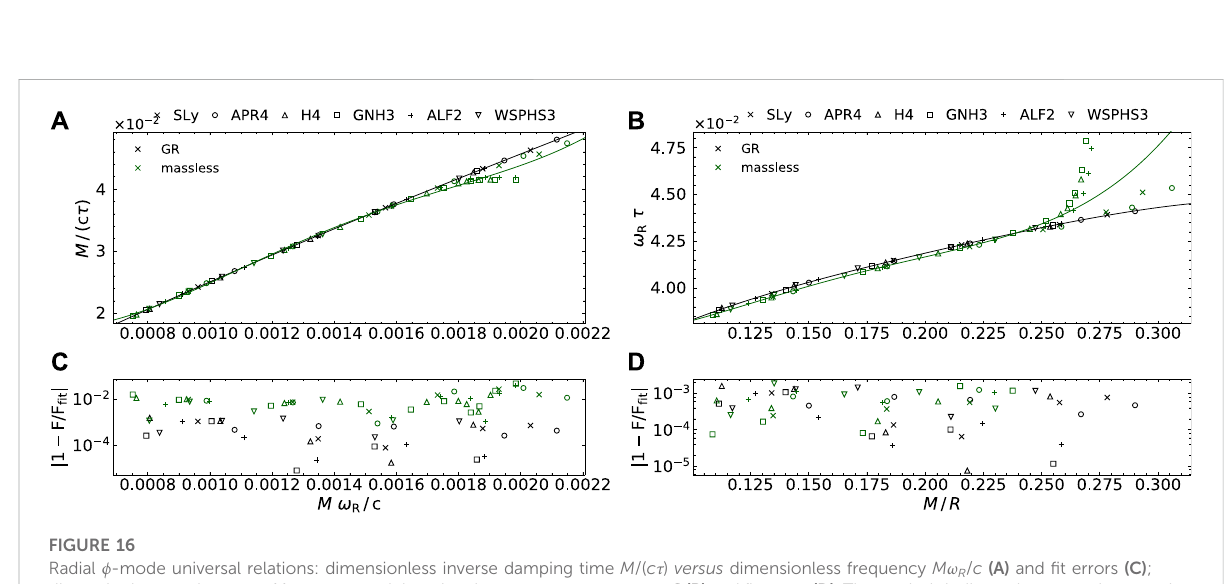
Similar universal relations for the damping time τ are shown in Figure 14. Again, generalrelativity yieldsexcellentrelations with mean errors of 0.02%. But here, the relations of the massless scalar – tensor theory produce mean errors of 0.4%. Here as well, a fi t up to M / R = 0.24 improves the universal relations of the massless case. The mean errors become 0.01%, which is of the order of the errors in GR. Figure 15 exhibits the dimensionless frequency ω R / ω o versus the compactness C = M / R ontheleftandthedimensionlessdampingtime τω o versus the compactness C on the right. As before, general relativity gives excellent universal relations. Similarly, a fi t for the massless case in the lower compactness range provides excellent universal relations,